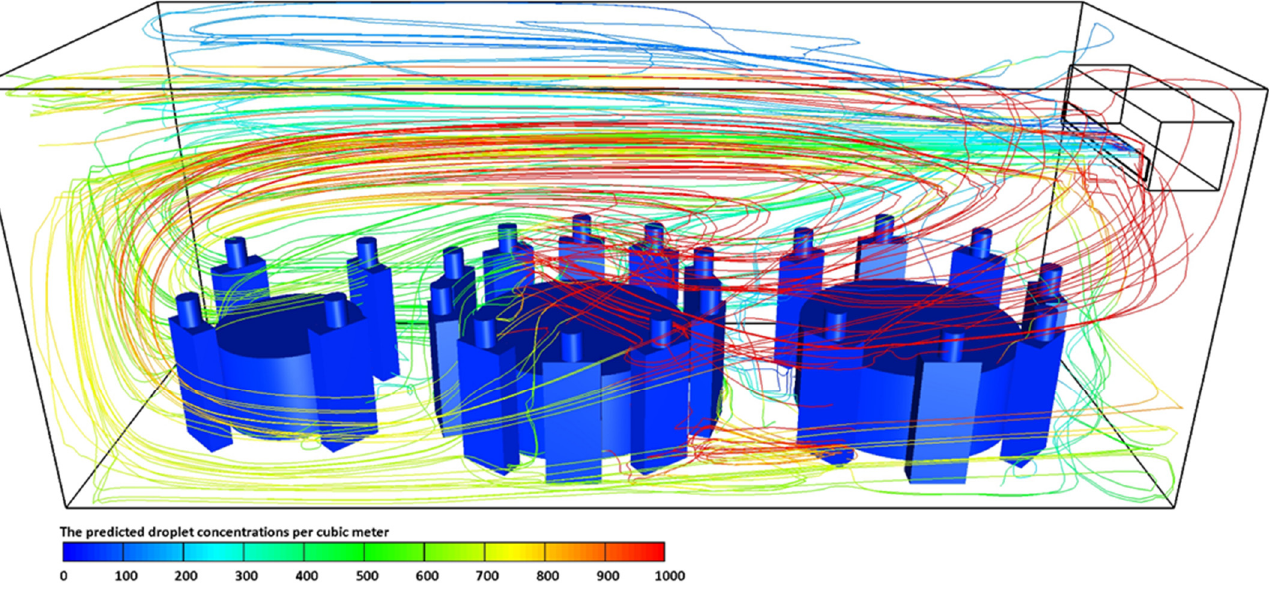
Figure 6. The predicted droplet concentrations per cubic meter exhaled from index case (T2C1) at t = 4500 s for case-2. The effect of air conditioning ventilation conditions on the concentration of contam- inated droplets is given in Figures 7–9. Figure 7 illustrate the number of contaminated droplets per cubic meter exhaled from the index case (T2C1) through normal breathing and talking in 4500 s (case-3). In case-3, the air conditioning ventilation rate per person was increased by one and half times. Further, in this case (case-3), it was assumed the air would come out of the air conditioning unit at an angle of 45 degrees. Figure 7 show that